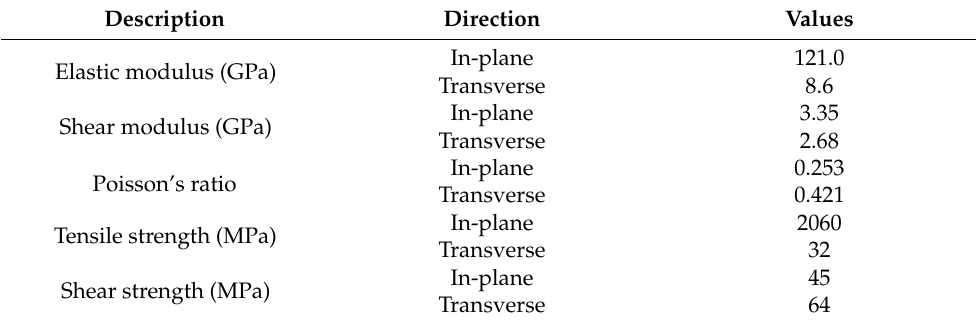
Table 5. Material properties of T700 carbon fibre (reproduced from [14], with permission from The Society of Naval Architects of Korea, 2022).